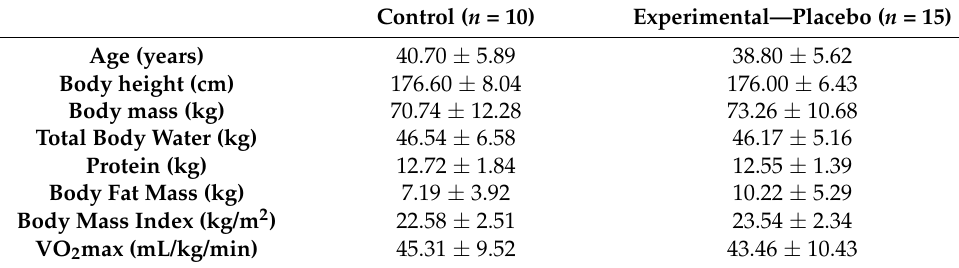
Table 1. Participants’ characteristics (mean,